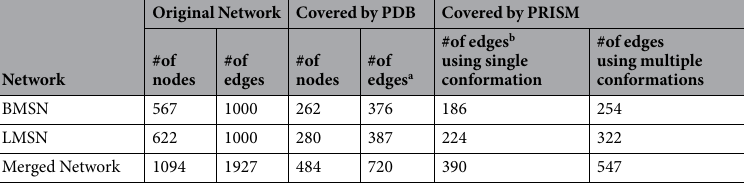
Table 1. Coverages of PDB and PRISM in our subnetworks. a If proteins at both ends of an edge have PDB structures. b If PRISM has a prediction for that